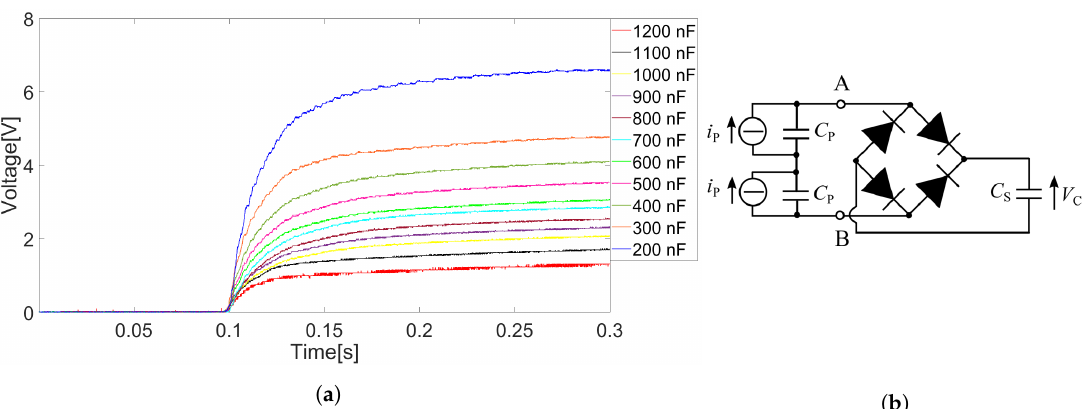
Figure 13. ( a ) voltage measured across the storage capacitance obtained with a single snap from the reversed to the inital undeformed configuration and ( b ) schematic circuit of the full-wave rectifier circuit with the storage